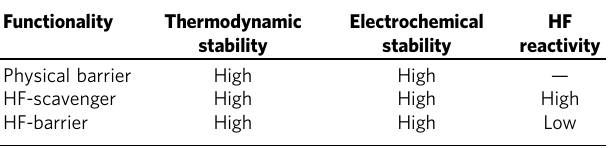
Materials selection: multi-objective optimization with weighted-sum and rank aggregation Rankings:Top-30 candidate coatings for each functionality (Figure 5) Figure 1 | The flowchart of the HT coating design framework. The filters applied on each design attribute are listed along with the number of compounds that pass each filter. G 0 is the excess reactivity limit. s - HF Table 1 | Coating functionalities and corresponding attributes used in the HT coating design